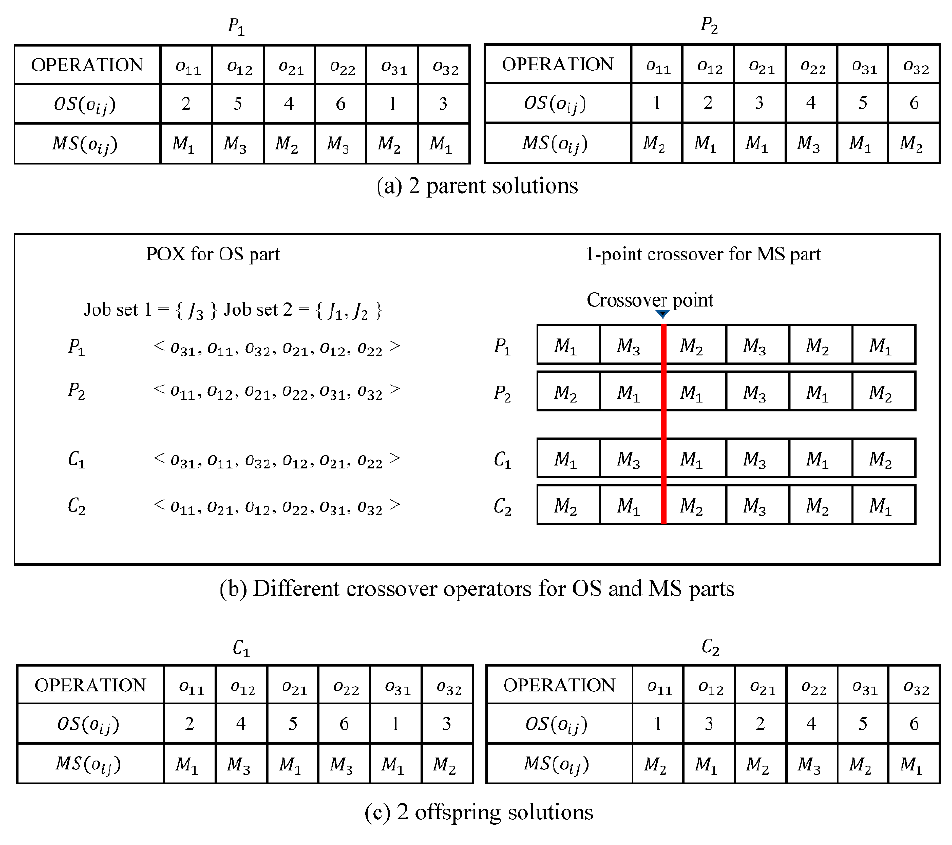
Figure 1. Decoding the multichromosome representation for the FJSP.